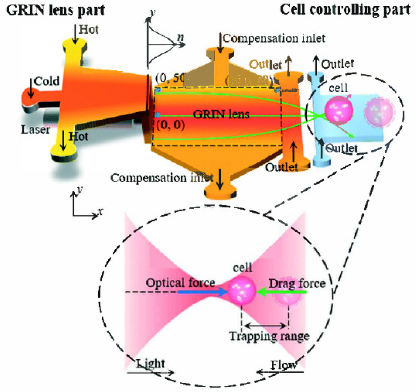
Figure 31. The schematic design of fluidic thermal GRIN lens for cell manipulation: The system includes a lens chamber and a cell trapping chamber. Five streams at different temperatures are injected into the microfluidic chip to form a gradient refractive index across the channel [137]. Reprinted with permission from Ref. [137]. 2017 Royal Society of Chemistry.